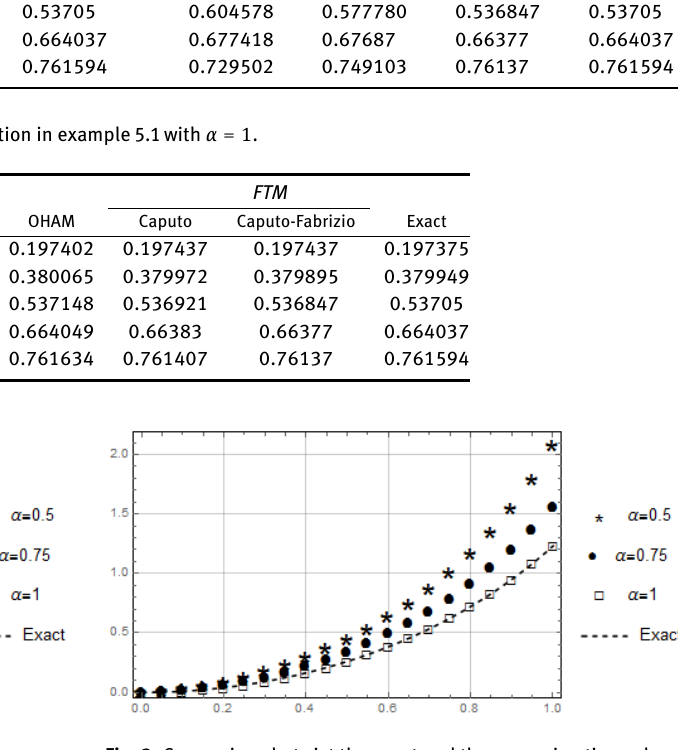
Fig. 2: Comparison betwixt the exact and the approximation so- lution with F -transform of test example 5.1 for value of n = 500 , τ = 0.002 and different values of α and t with Caputo derivative.